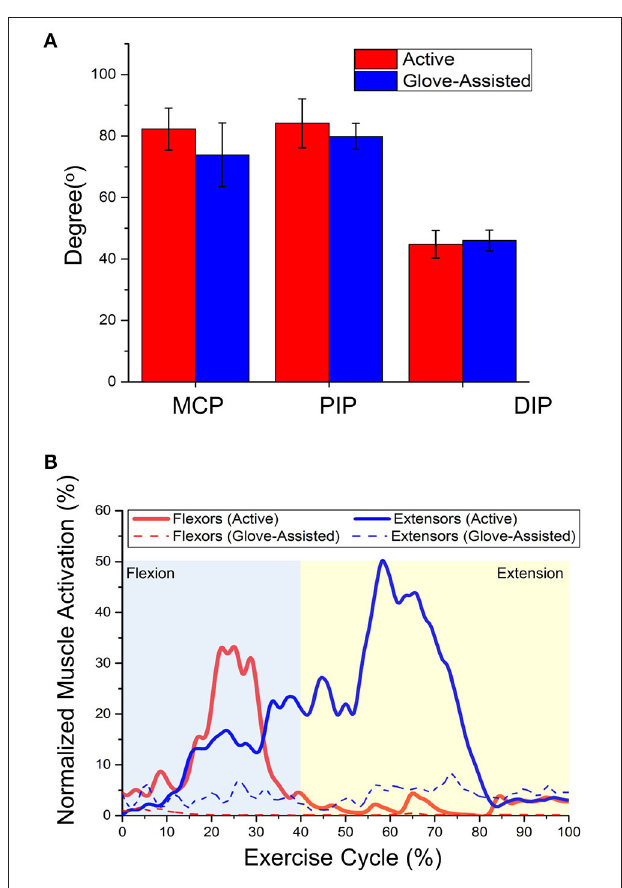
FIGURE 7 | (A) Averaged range of motion of individual finger joints of five participants during active and glove-assisted trials. MCP, Metacarpophalangeal joint; PIP, Proximal interphalangeal joint; DIP, Distal interphalangeal joint. (B) Averaged muscle activation profiles of finger flexors and extensors of one representative subject (Subject 2) during active and glove-assisted trials. Exercise Cycle, Hand closing followed by